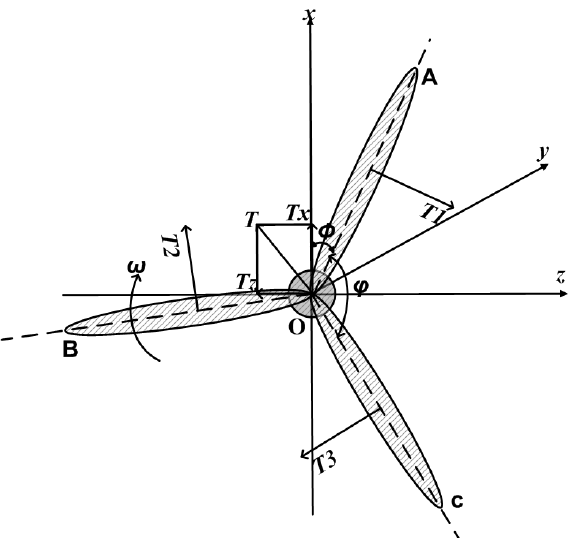
Figure 6 . Tangential force on Wind